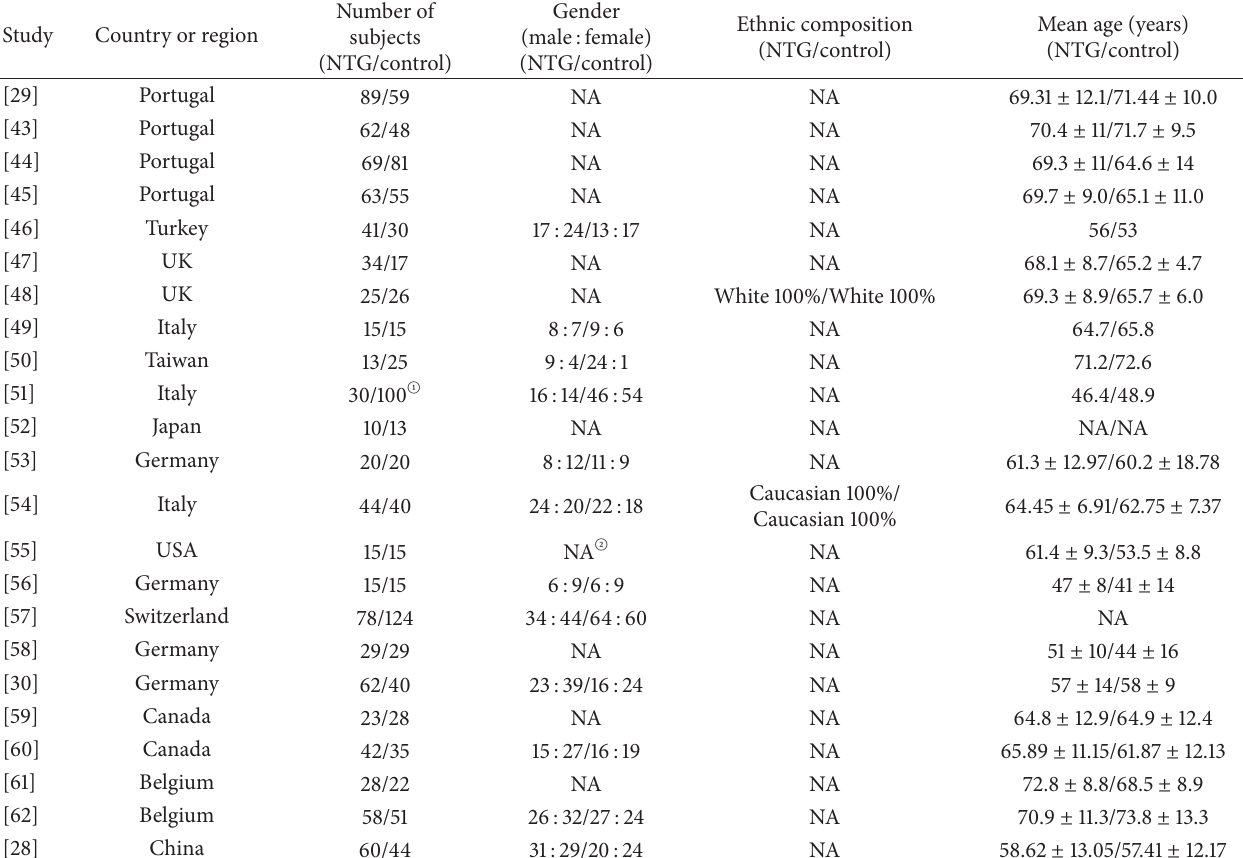
Table 2: Basic study data of the included studies.